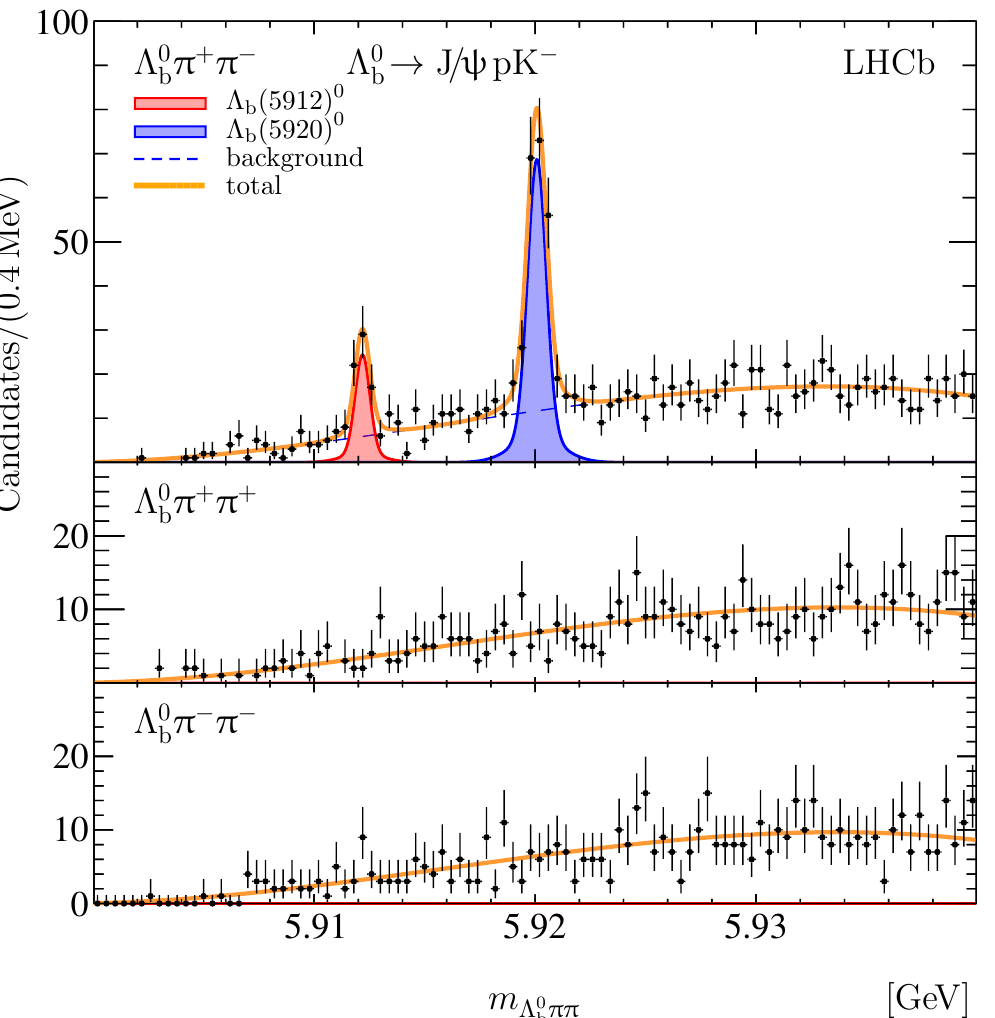
Figure 6 . Mass spectra of selected (top) (cid:3) 0 binations for the (cid:3) 0 J = pK (cid:0) sample. A simultaneous (cid:12)t, described in the text, is superimposed. b !